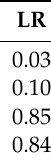
Table 1. Optimal hyperparameters (HP opt ) and model performance on test set data. The differences in performance can be considered negligible.